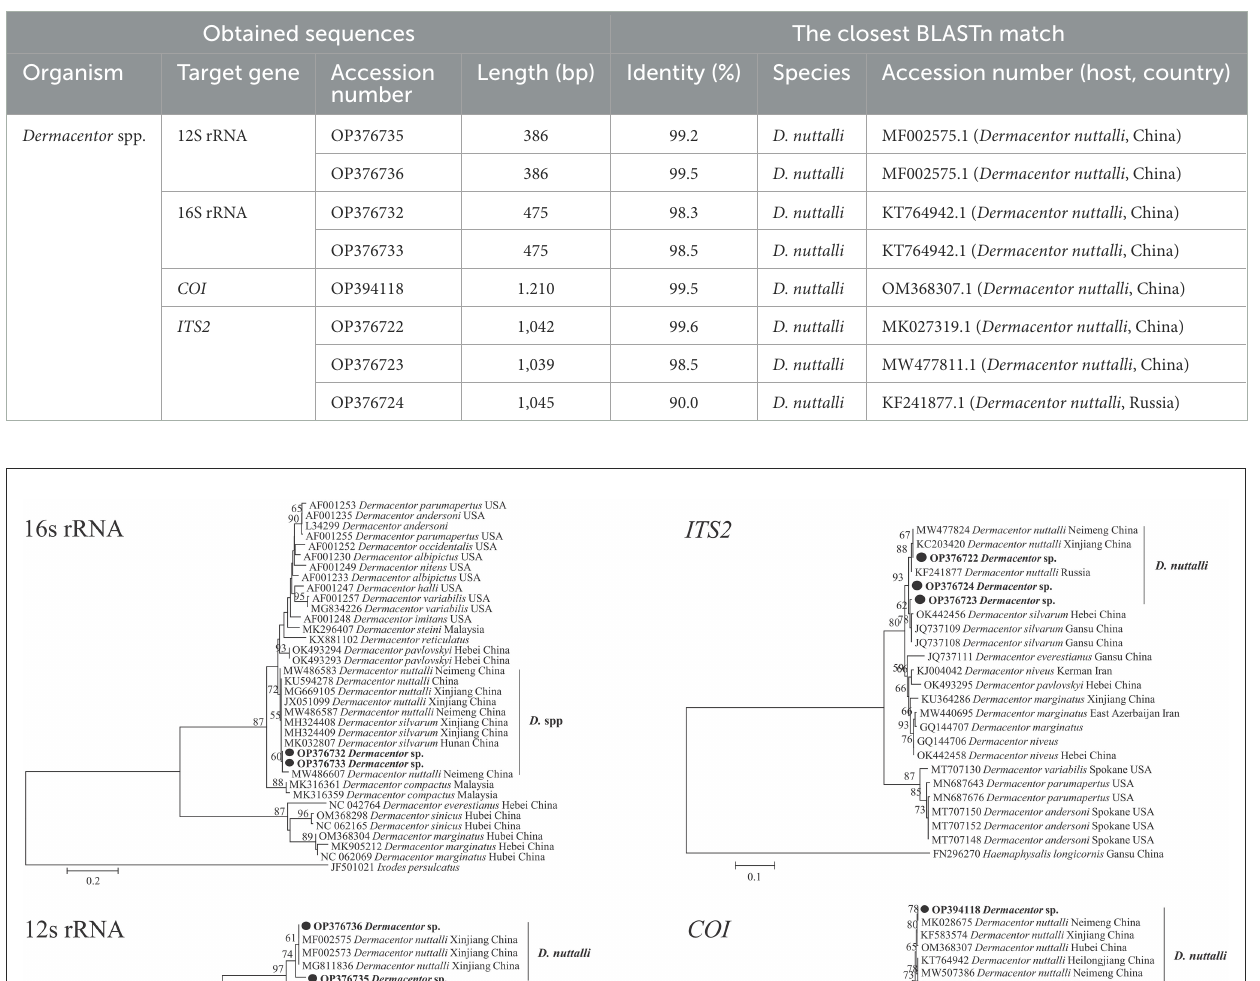
TABLE 2 Dermacentor spp. sequences obtained in this study.